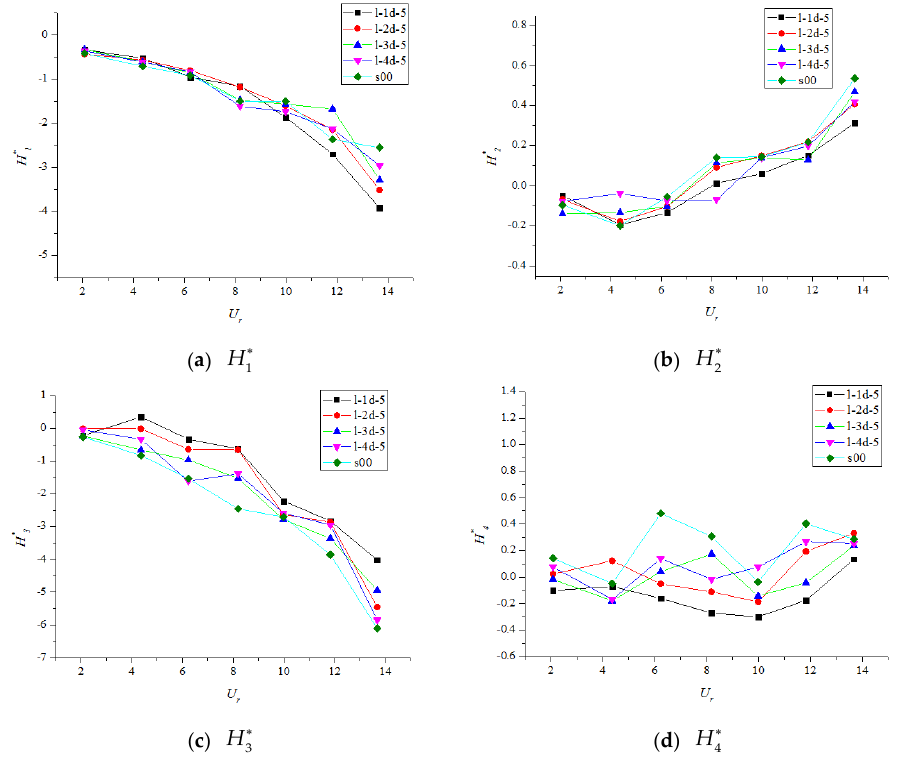
H i ( i = 1 − 4) for test cases with di ff erent suction positions.